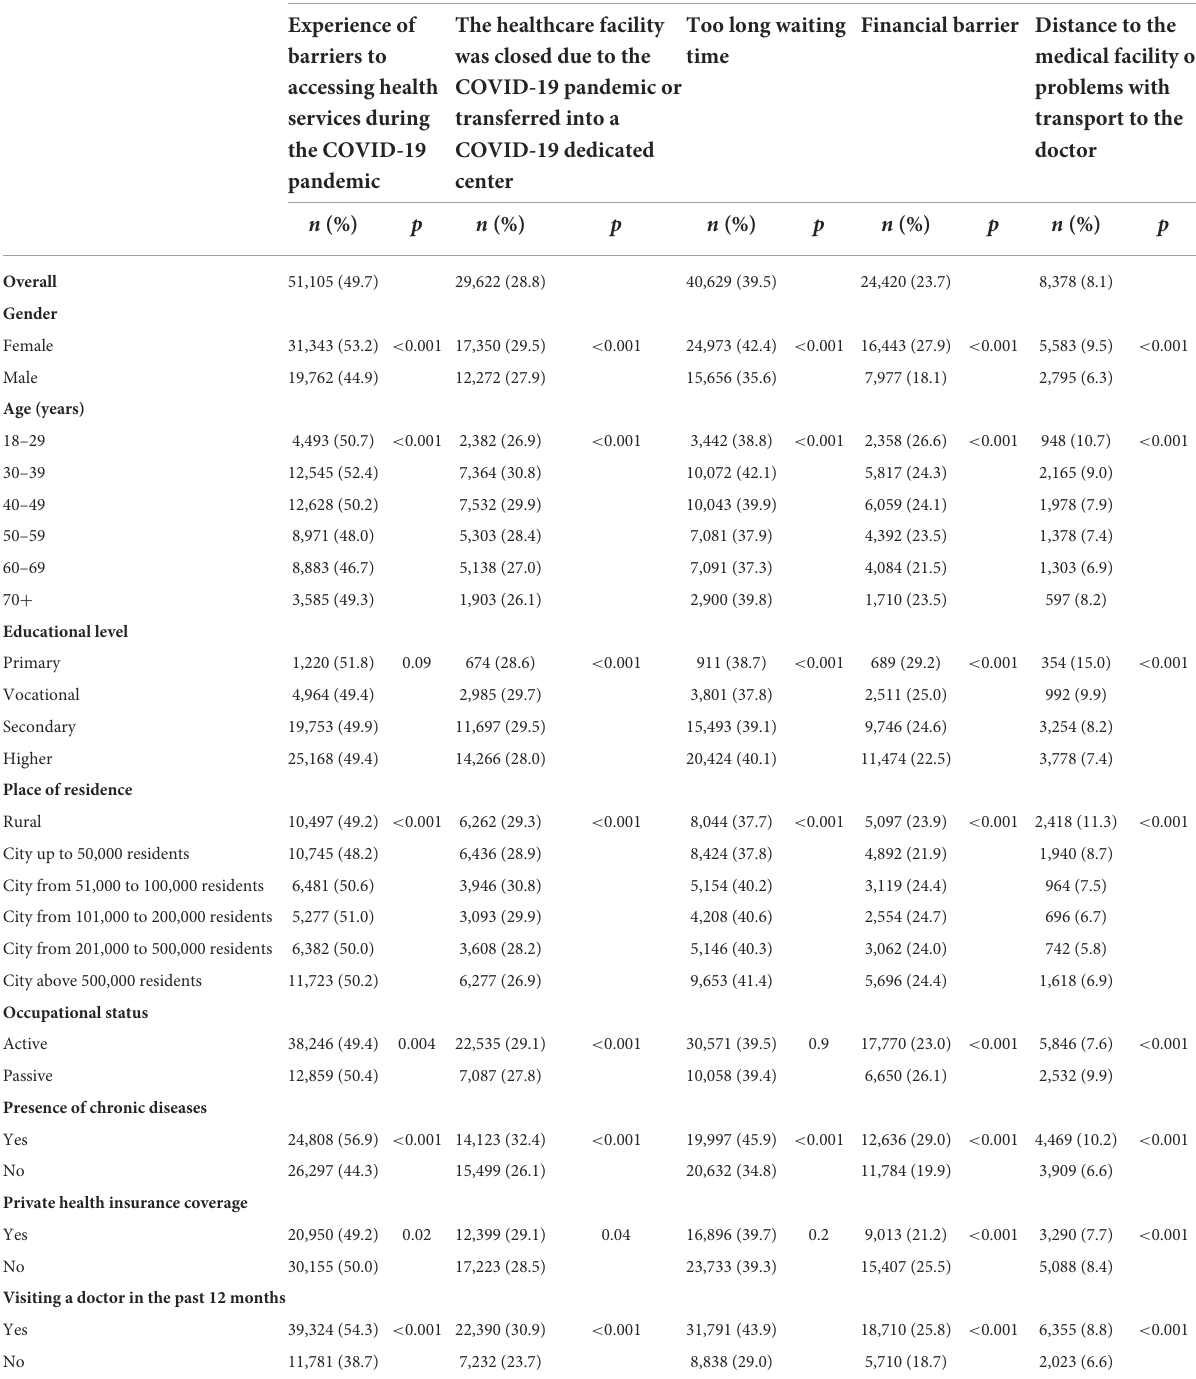
TABLE 2 Barriers to accessing health services during the COVID-19 pandemic by sociodemographic factors ( n = 102,928). Variable Barriers to accessing health services during the COVID-19 pandemic — the